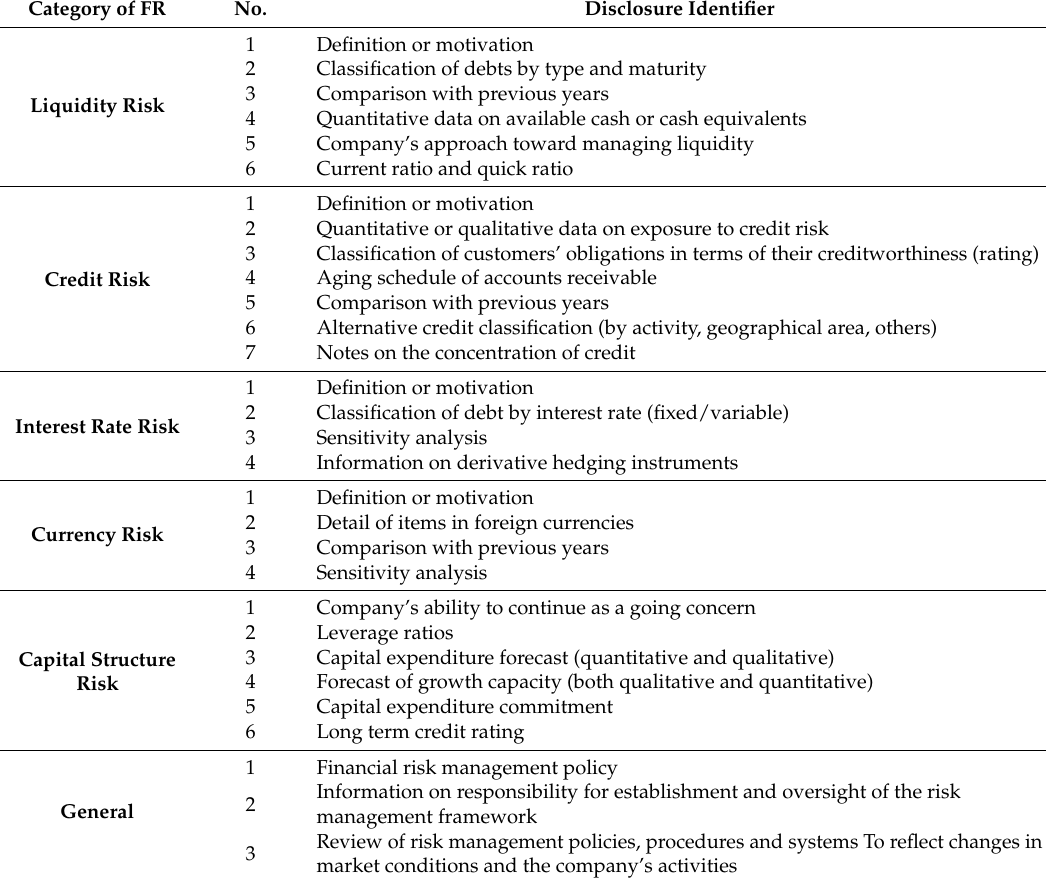
Table 1. Grid of risk reporting. FR—financial